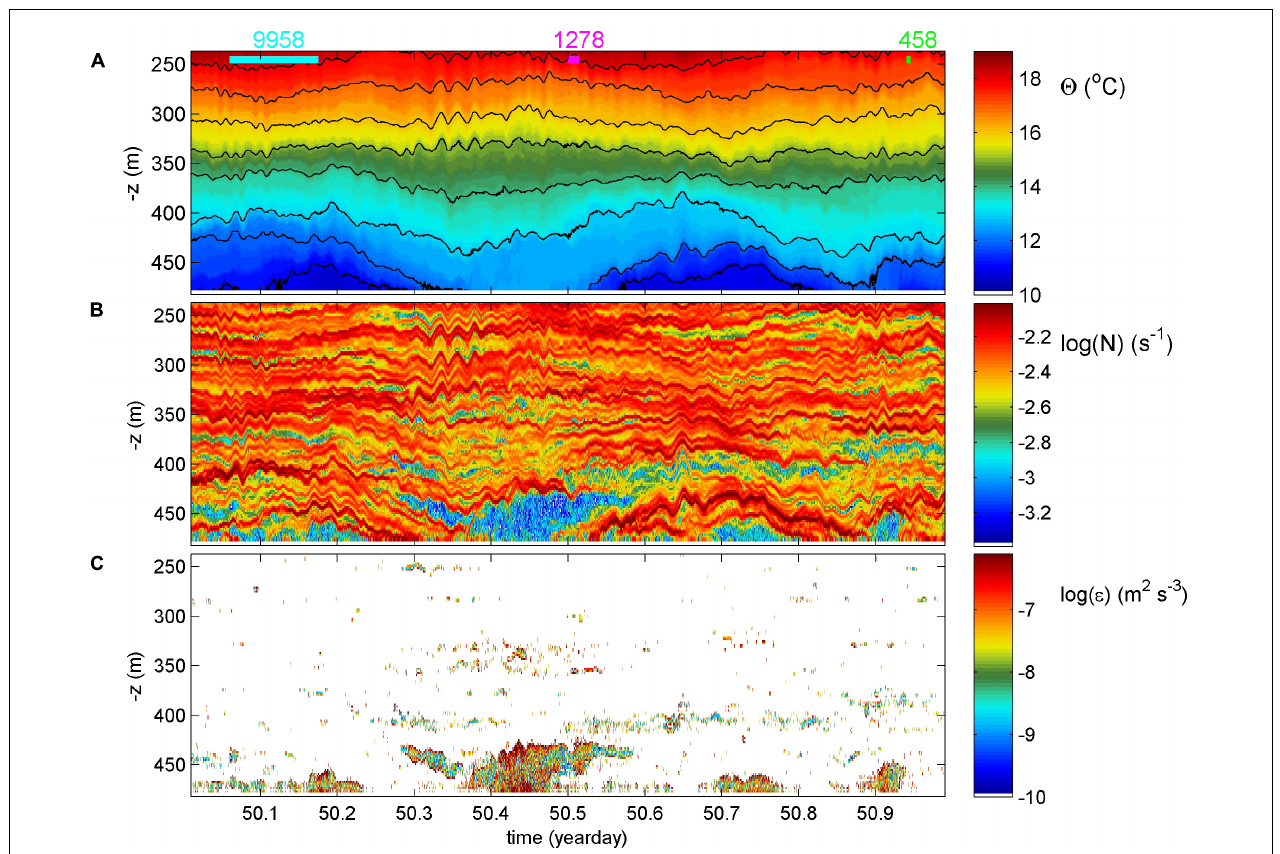
FIGURE 9 | One day detail from Figure 5A , MN. (A) Conservative Temperature. Black contours are drawn every 1.0 ◦ C. The horizontal bars indicate from left to right maximum (light-blue), mean (purple) and minimum (green) buoyancy periods. (B) Logarithm of buoyancy frequency per vertical increment and per time step. (C) Logarithm of dissipation